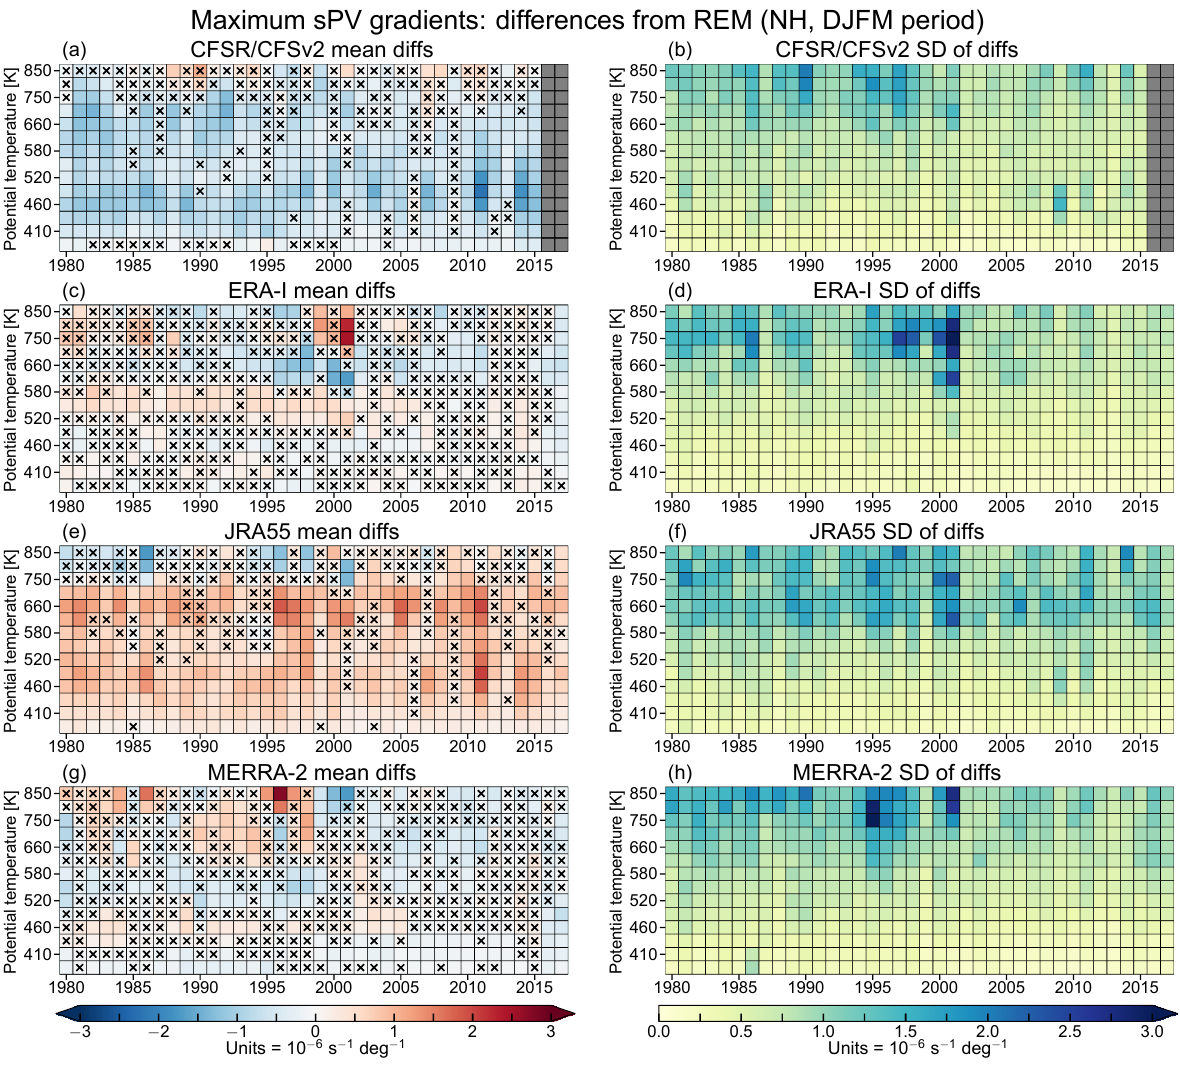
Figure 11. As in Fig. 10 but for the